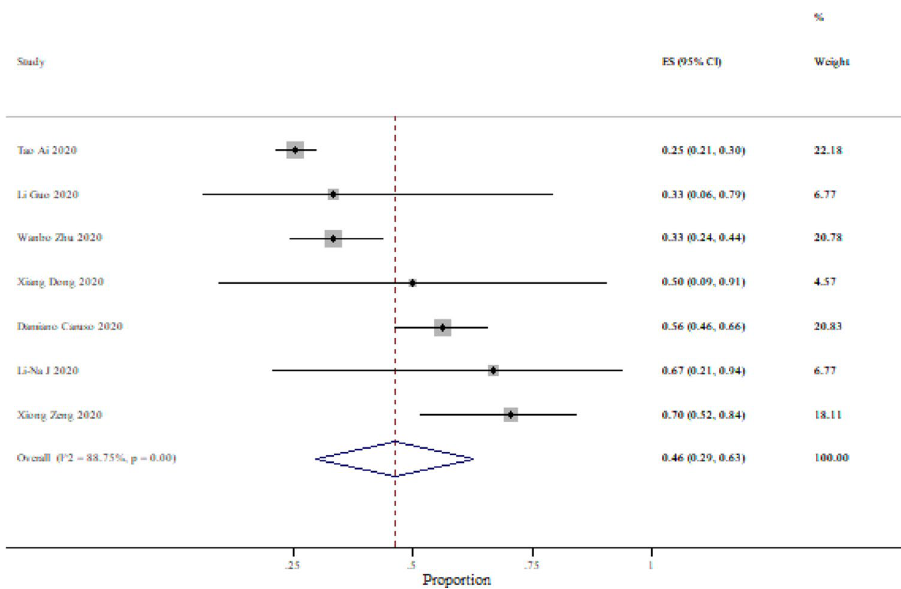
Figure 4. Summary of specificity and 95% CI, generated by the